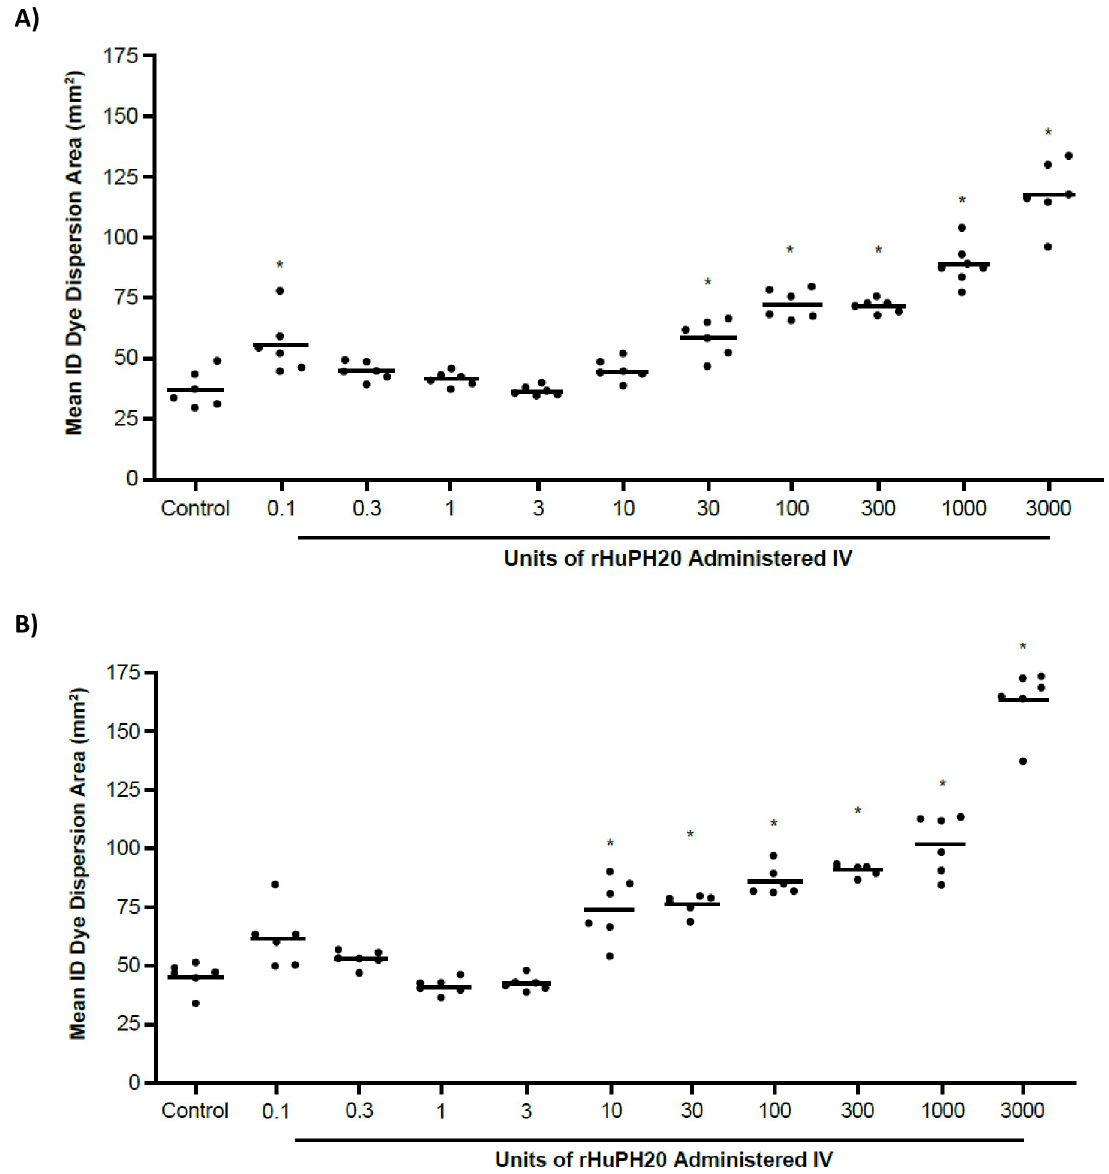
Fig 5. Dye dispersion assay validation: Effect of ascending systemically administered doses of rHuPH20 on intradermal dye dispersion. Measurement of dispersion area (A) 5 minutes and (B) 15 minutes post-dye injection in the skin. Each point represents the mean of duplicate measurements from one animal; the bar represents the mean for all animals. Asterisk denotes statistical significance of P < 0.05 versus control. IV, intravenously; rHuPH20, recombinant human hyaluronidase